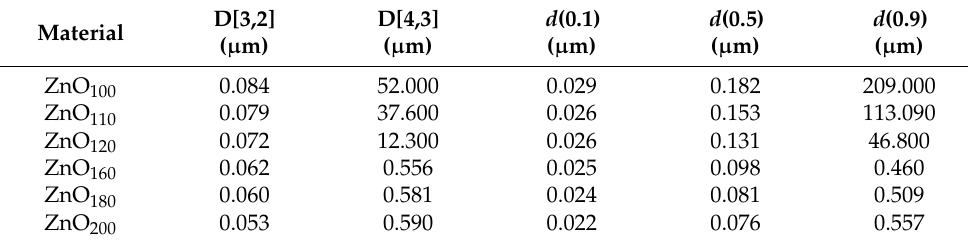
Figure 5. Particle size distribution of ZnO samples synthesized hydrothermally at 100, 110, 120, 160, 180, and 200 °C. Table 2. Particle size distribution data of ZnO x synthesized at various temperatures (100–200 °C), where x subscripts indicate the exact reaction conditions.